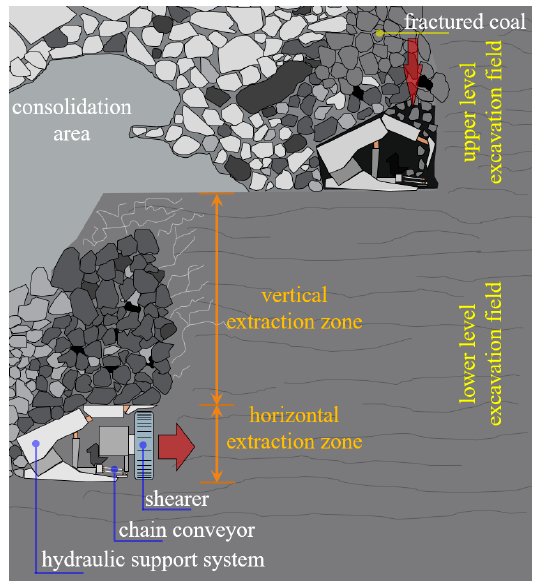
Figure 1. Schematic illustration of the Velenje mining method (VMM). Adapted from Jeromel et al., 2010 [23] and Likar et al., 2012 [24].